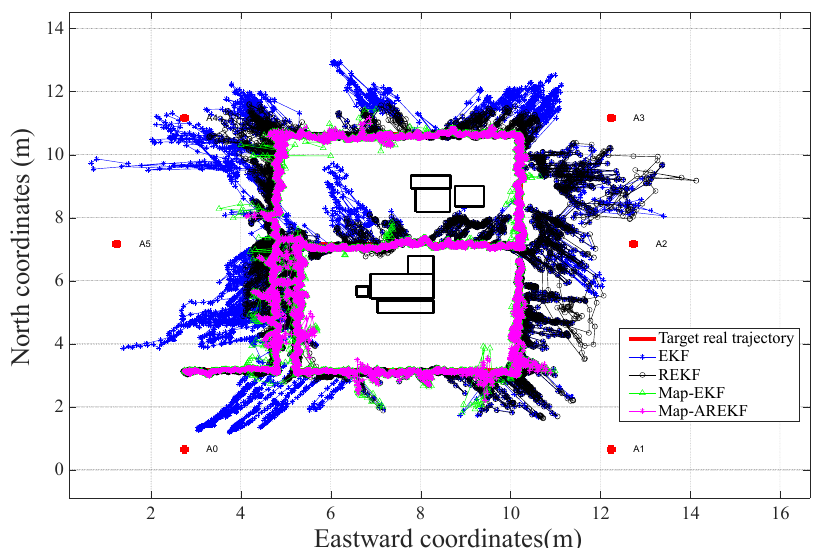
Figure 27. Comparison of the solution results of the four localization algorithms for Experiment 4.